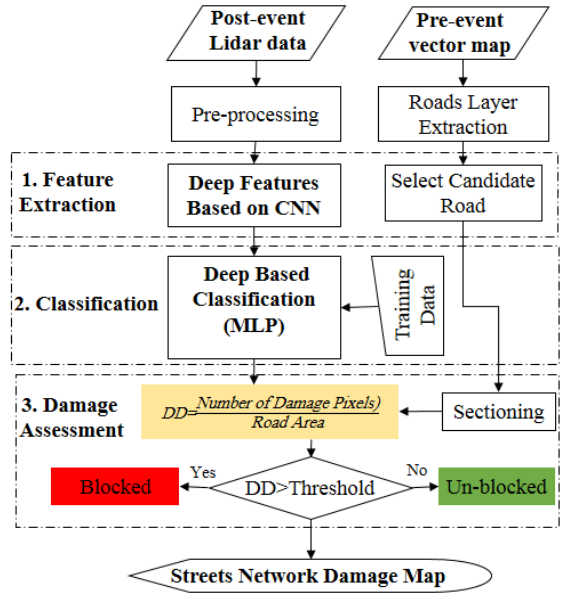
Figure 1. The proposed DL-based framework for damaged roads detection using LiDAR data.